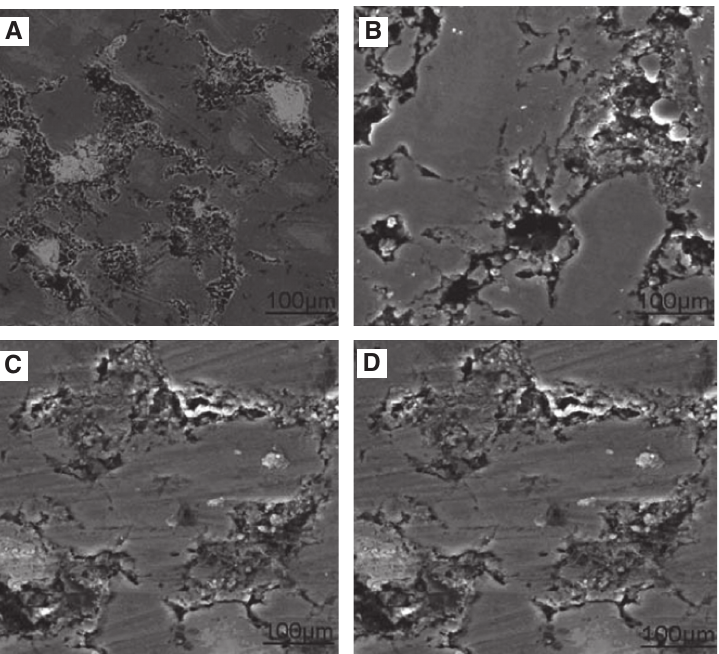
Figure 3 Microstructure of self-lubricating materials with different NaF addition amounts: (A) 5%, (B) 10%, (C) 15%, and (D) 20%.